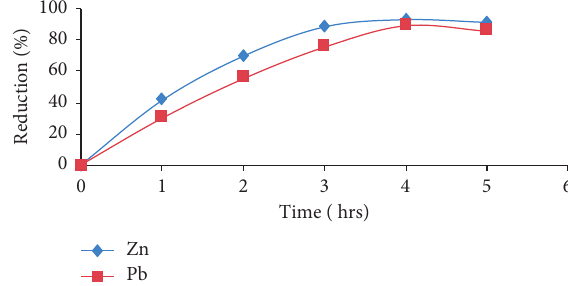
Figure 8: Effect of 1.5g ZSM-11 on the removal of Pb 2+ and Zn 2+ from aqueous